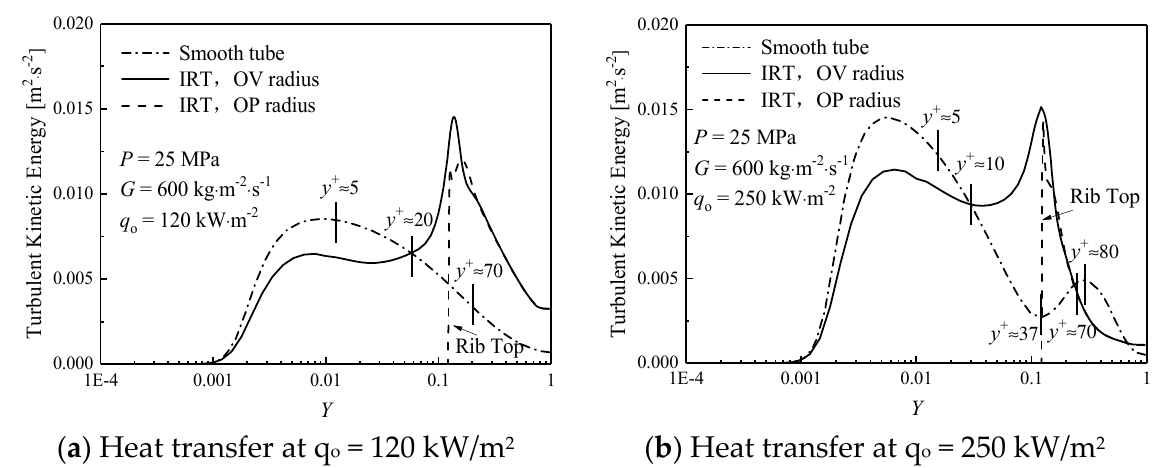
Figure 11. Comparison of radial distribution of turbulent kinetic energy. As seen in Figure 11a, in smooth tube, the turbulent kinetic energy increases first and